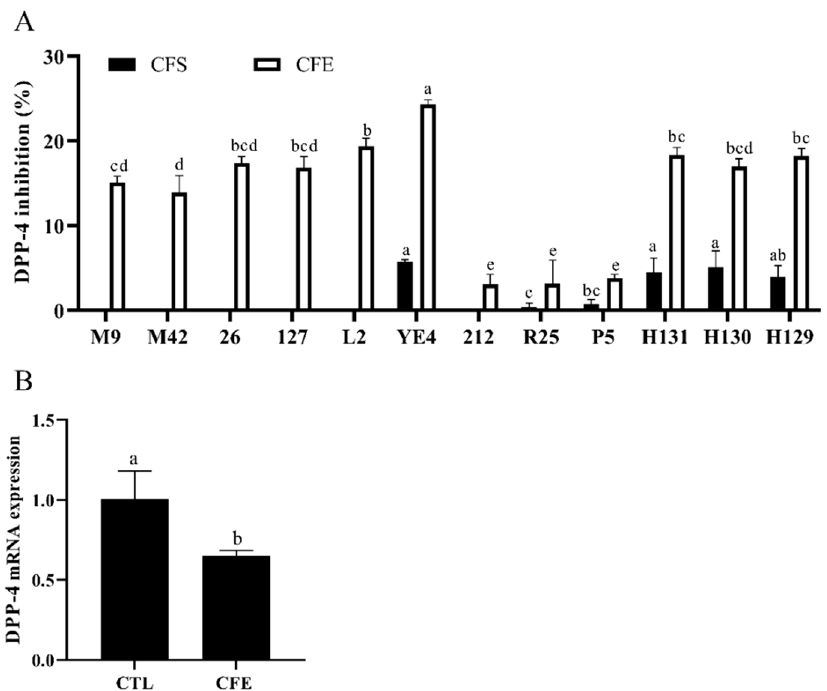
Figure 2. ( A ) Effects of different lactic acid bacteria (LAB) strains on the DPP-4 inhibitory activity in Caco-2 cells. CFS, cell-free excretory supernatants; CFE, cell-free extracts. ( p < 0.05). ( B ) Effects of YE4-CFE on the mRNA expression of DPP-4 in Caco-2 cells. CFE, treatment group after YE4-CFE interacted with Caco-2 cells; CTL, control group. Each value represents the mean ± standard deviation ( n = 3). Different letters (a–e) on the column with the same color indicate significant differences ( p < 0.05).